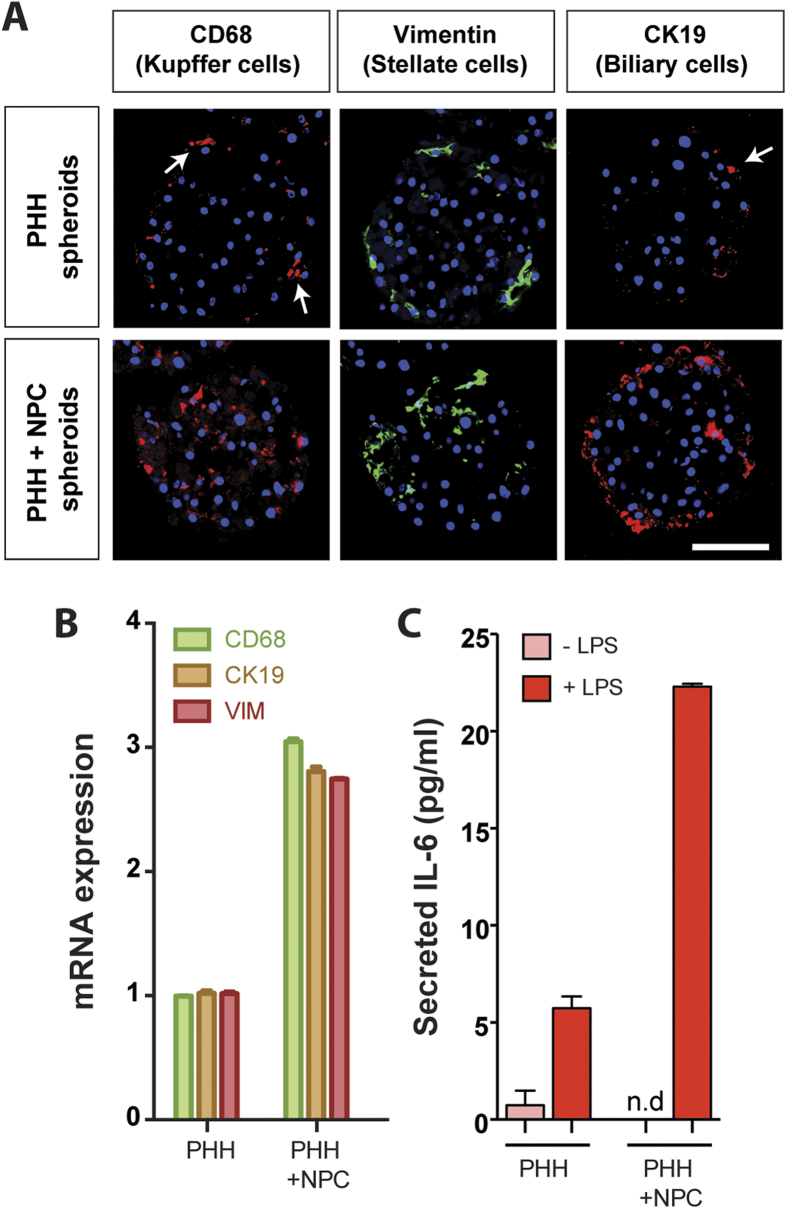
PHH spheroids can be successfully co-cultured with non-parenchymal Kupffer, stellate and biliary cells.Immunofluorescent stainings (A) as well as qPCR analyses (B) reveal the presence of Kupffer cells (CD68), stellate cells (vimentin) and biliary cells (CK19) in co-cultured spheroids at day 8 (bottom row). Note that some PHH preparations can already contain low numbers of NPCs (top row). (C) Co-cultured Kupffer cells were responsive to LPS-mediated activation as evidenced by elevated IL-6 secretion.